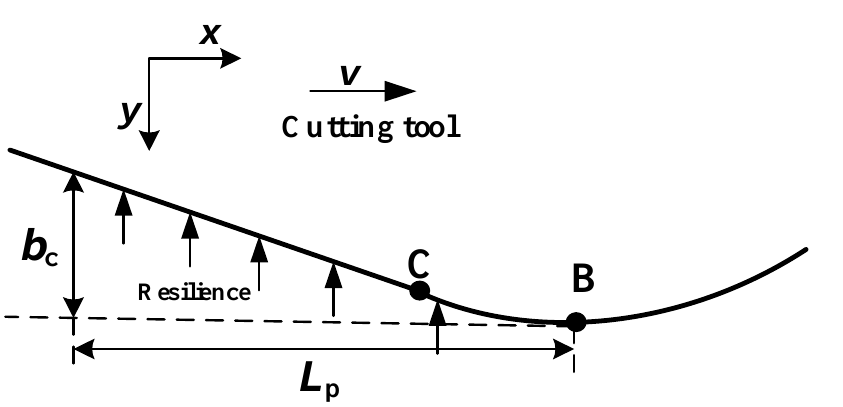
Figure 14. The schematic diagram of rebound zone.